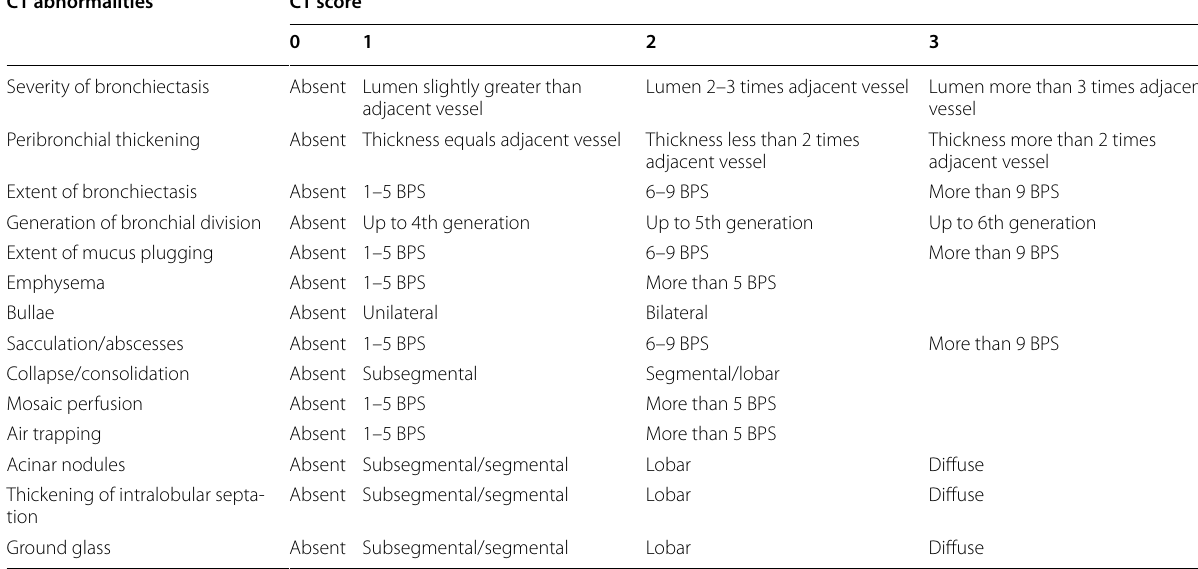
Table 1 Modified Bhalla CT scoring system, described by Judge et al.